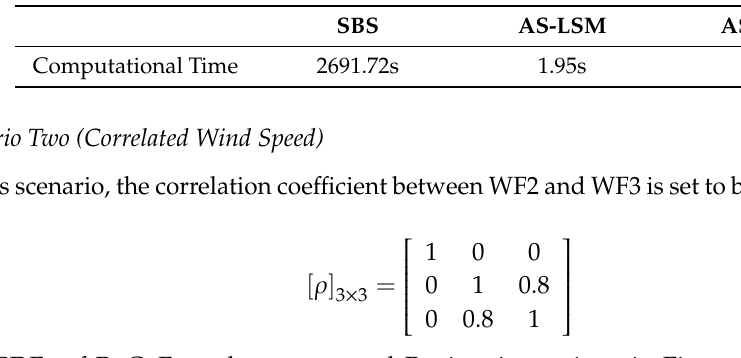
Table 4. The computational time of SBS, AS-LSM, and